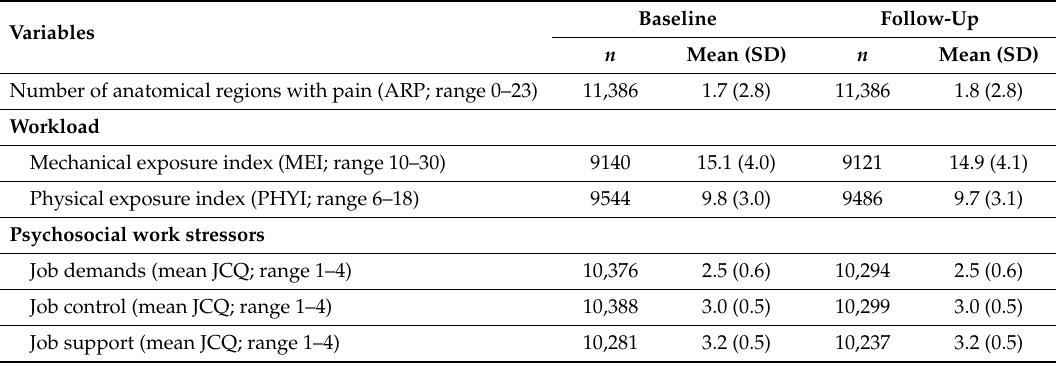
Table 2. Number of anatomical pain regions, workload, and psychosocial work stressors over